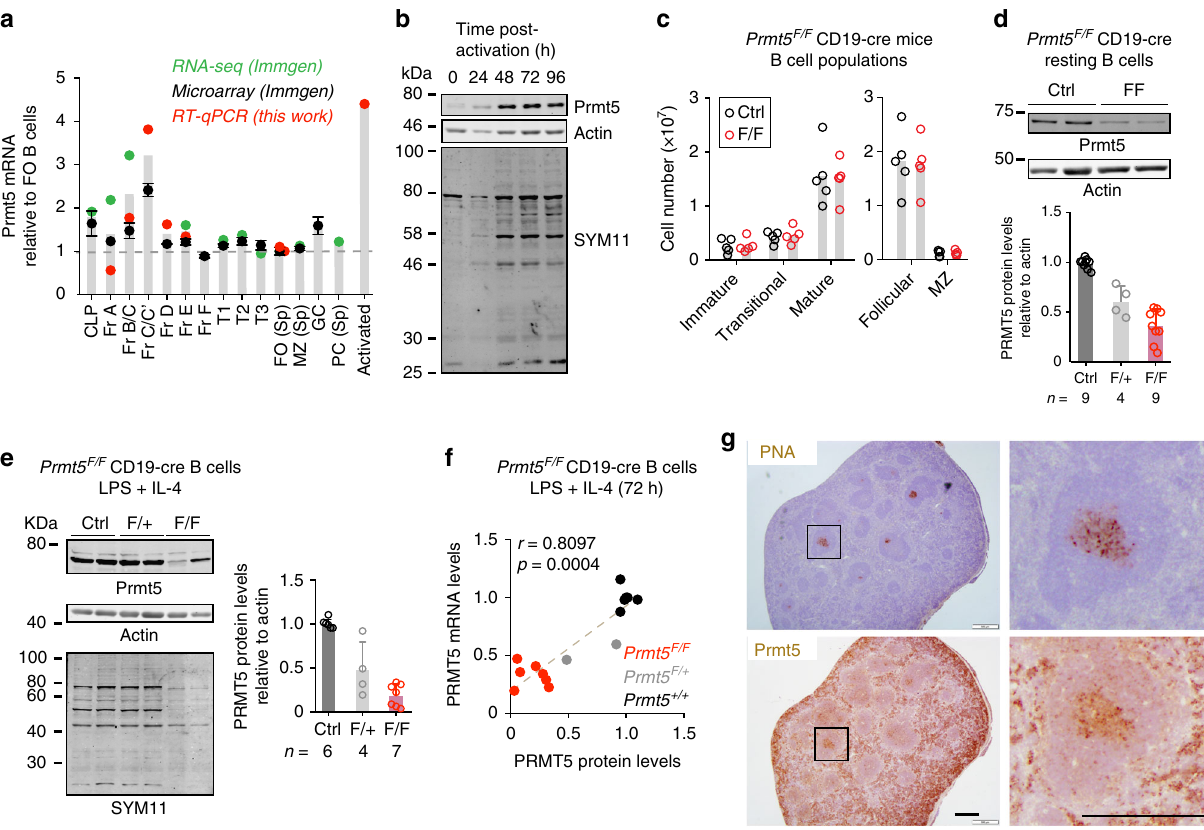
Fig. 1 Regulated Prmt5 expression in B cells. a Prmt5 transcript levels in B cell stages from the indicated datasets, each normalized to follicular (Fo) B cells. RT-qPCR data were normalized to Actin mRNA and obtained from a pool of two mice sorted for Hardy ’ s BM fractions (FrA to E), or from splenic B cells from two mice stimulated ex vivo with LPS and IL-4 for 48 h (Activated). CLP common lymphoid progenitor, T1 – T3 transitional B cells, MZ marginal zone B cells, PC plasma cells, Sp spleen. b Prmt5 expression kinetics and sDMA-modi fi ed proteins by WB in extracts of WT splenic B cells stimulated with LPS (5 µ g/mL) and IL-4 (5 ng/mL) probed with anti-PRMT5, -Actin (as loading control), and -sDMA (SYM11) antibodies. c Absolute number of B cell subpopulations in the spleen of CD19-cre (Ctrl) and Prmt5 F/F CD19-cre (F/F) mice. Individual mice (dots) and mean (bars) values are plotted. Gatings in Supplementary Fig. 1B. d Representative WB of resting splenic B cell extracts from CD19-cre (Ctrl) and Prmt5 F/F CD19-cre (F/F) mice. Means + s.d. levels of Prmt5 normalized to Actin quanti fi ed from n mice by WB are plotted relative to the Ctrl. e Representative Prmt5, Actin, and sDMA (SYM11) WB and quantitation as in d , in extracts of splenic B cells activated with LPS (5 µ g/mL) and IL-4 (5 ng/mL) for 72 h. f Prmt5 mRNA (by RT-qPCR) as a function of Prmt5 protein (by WB) at 72 h post-stimulation for individual mice. Spearman ’ s test correlation coef fi cient ( r ) and p -value ( p ) are indicated. g Representative immunohistochemical staining for PNA as GC marker and Prmt5 on consecutive mouse spleen sections at day 14 post-immunization. Scale bars, 500 µ